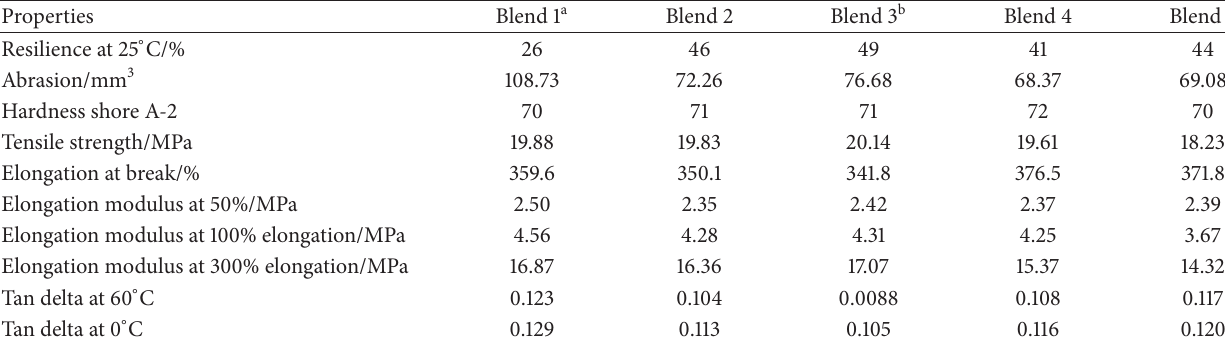
Table 5: Mechanical properties of